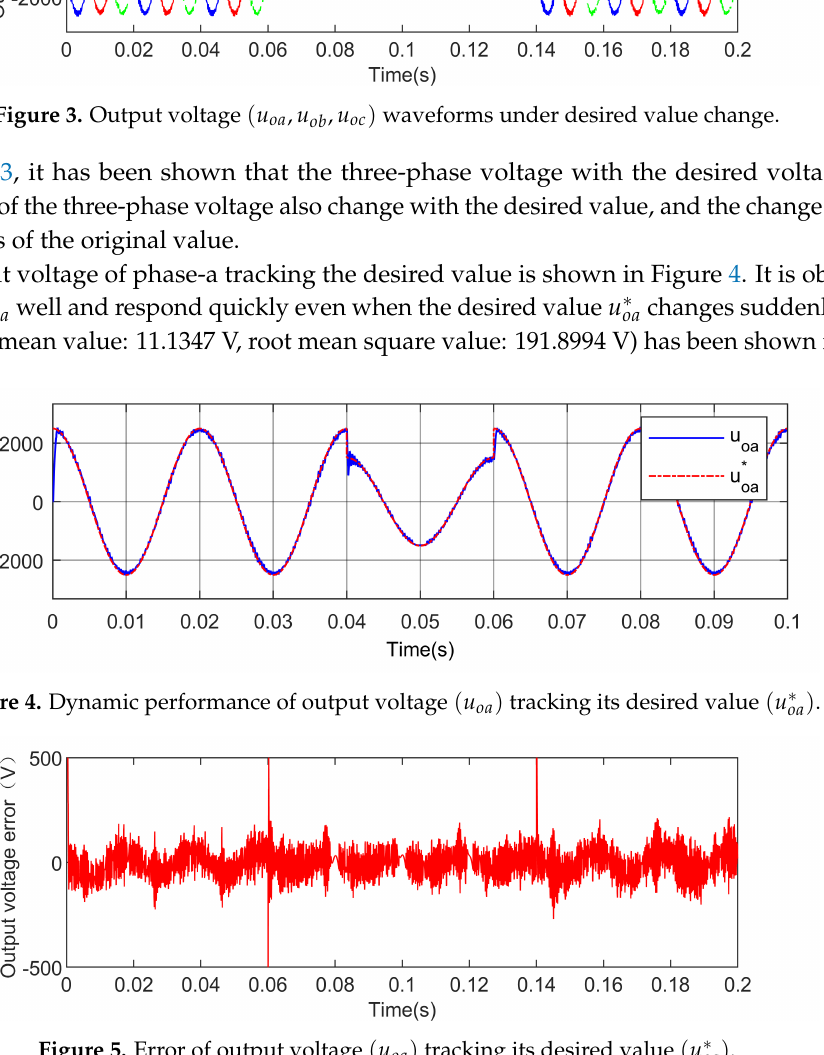
Figure 5. Error of output voltage ( u oa ) tracking its desired value ( u ∗ oa )